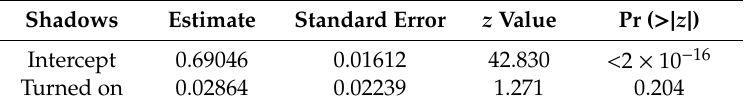
Table 8. Results of the logistic regression analysis of the